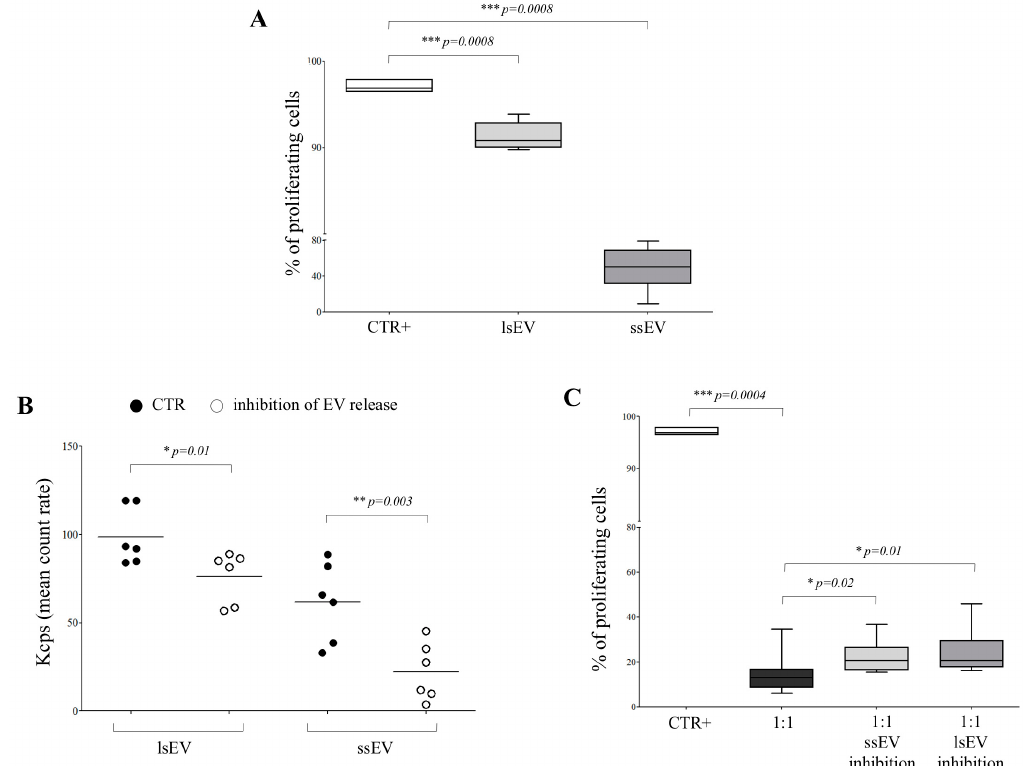
Figure 5. Cell proliferation assay on T cells exposed to hAEC-derived EV. ( A ) CD4 + T cells stimulated with anti-CD3/CD28 beads (white box) were cocultured with hAEC-derived lsEV (light grey box) or ssEV (grey box). Results are expressed as % of proliferating cells. Mean of 9 experiments ± SD is shown. p values are indicated where differences are statistically significant. ( B ) Concentration of lsEV and ssEV was assessed in supernatants from hAEC either untreated (black dots) or treated with inhibitors of ssEV or lsEV release (white dots). Results are expressed as the mean count rate (Kcps). ( C ) CD4 + T cells stimulated with anti-CD3/CD28 beads (white box) were cocultured with hAEC, either untreated (black box) or treated with inhibitors of ssEV (light grey box) or lsEV (grey box) release, at hAEC:T cell ratio of 1:1. Results are expressed as % of proliferating cells. Mean of 9 experiments ± SD is shown. p values are indicated where differences are statistically significant.